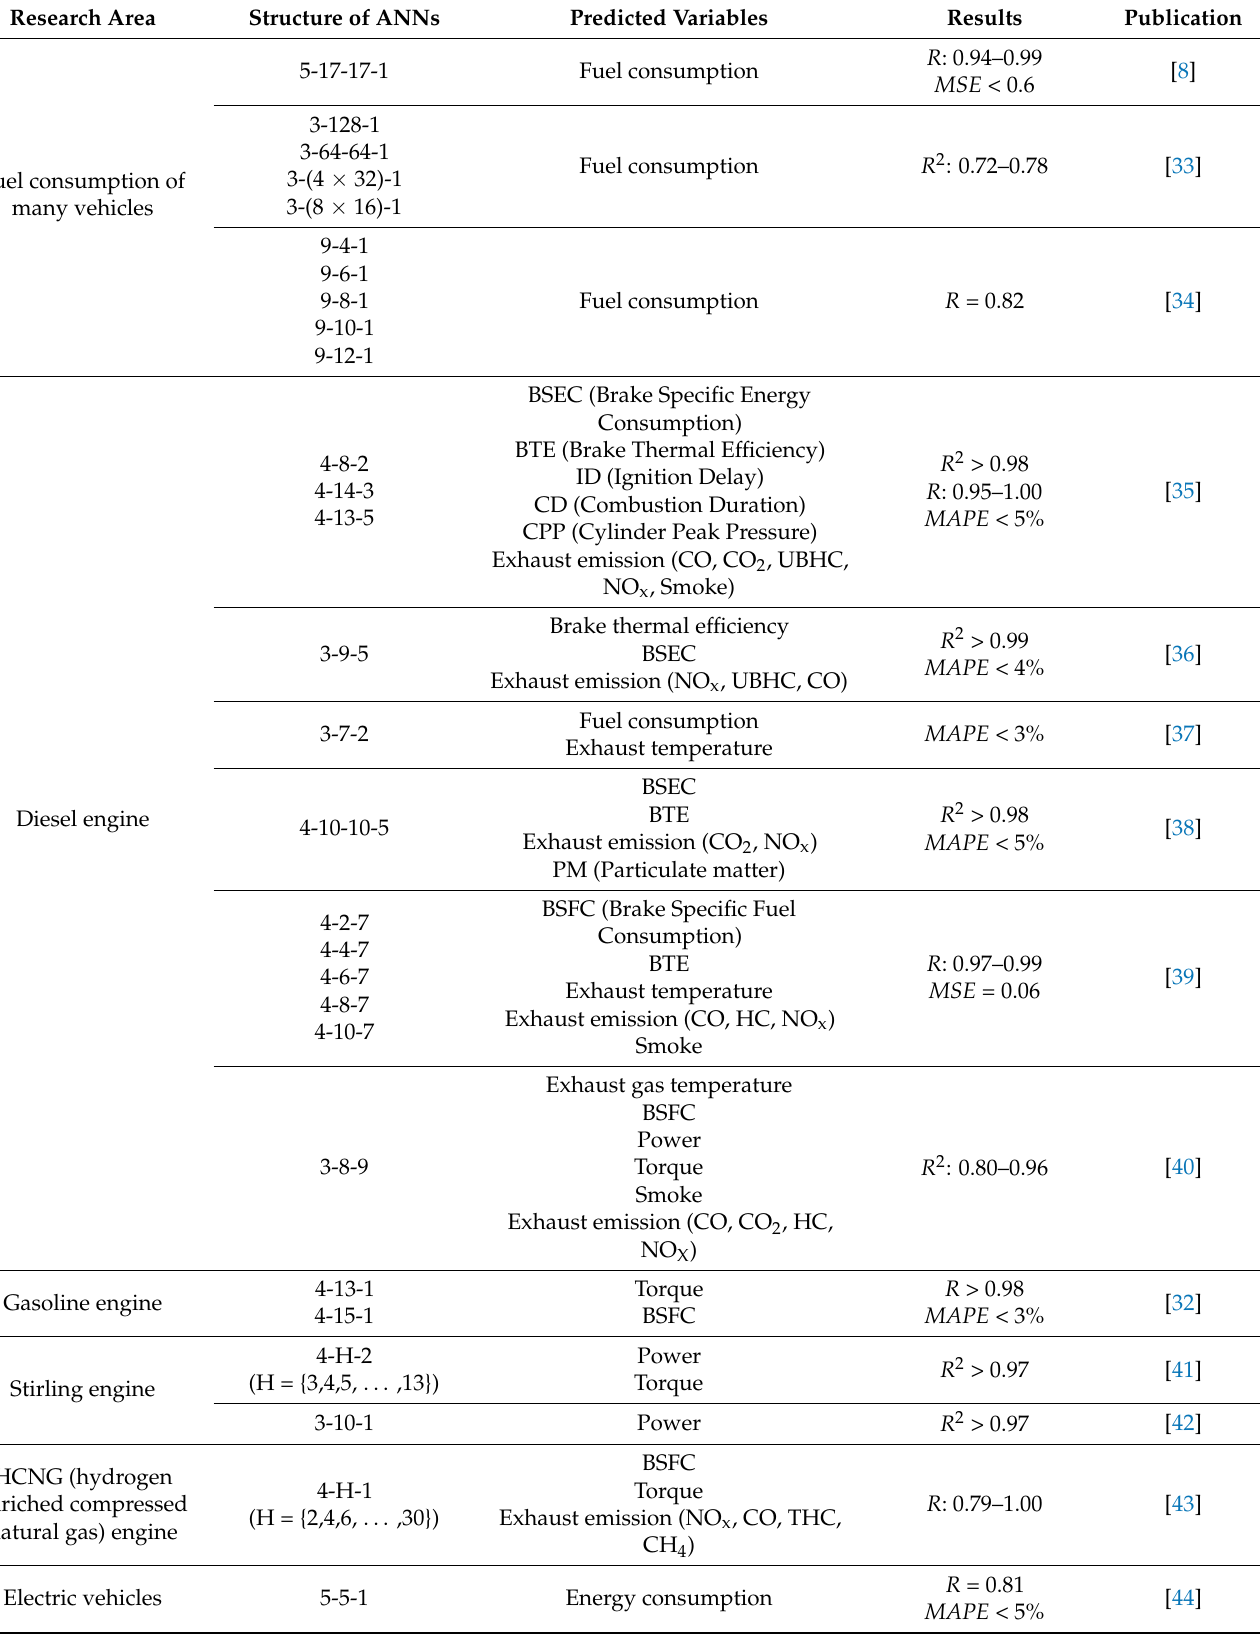
Table 1. Comparative analysis of research results obtained in the selected research